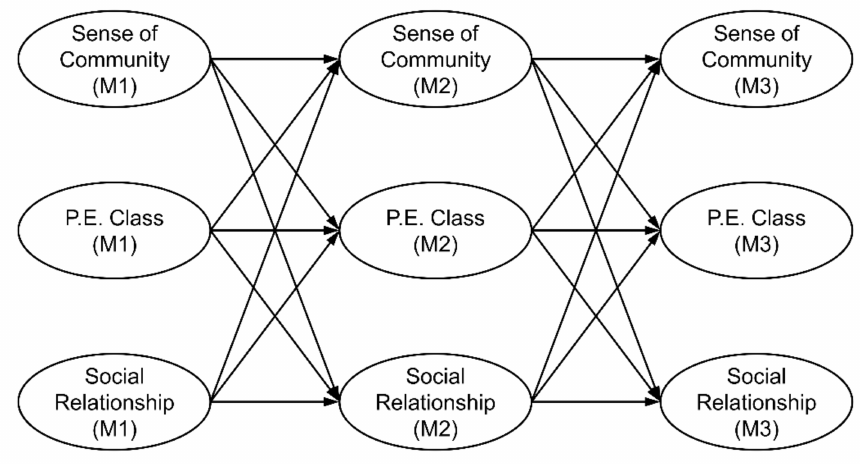
Figure 1. Research